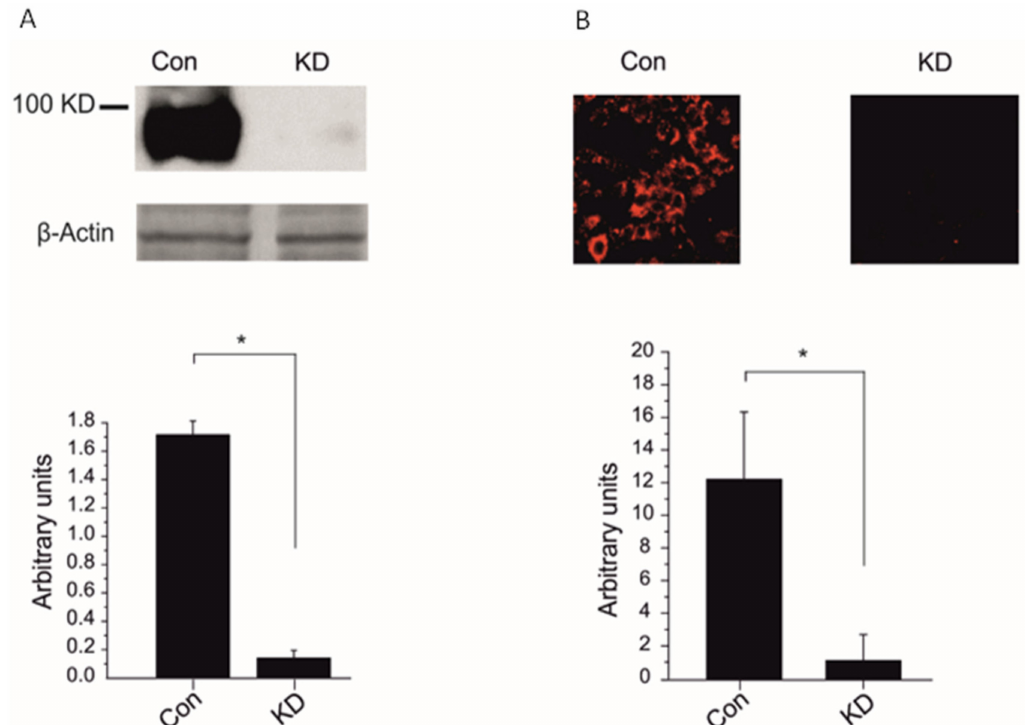
Figure 1. CRISPR/Cas 9 knocked down the δ -ENaC subunit in the A549. ( A ) Upper panel, A549 cell lysate blotted against anti δ -ENaC and β -Actin antibodies. Representative western blot out of three independent biological replicates is shown. A549 cells transfected with either CRISPR/Cas 9 control plasmid (control) or CRISPR/Cas 9 δ -ENaC KO plasmid (KD). The lower panel; mean values of quantitation of three western blots is shown. ( B ) Upper panel, representative confocal microscope image of anti δ -ENaC antibody, is shown. A549 cells transfected with either CRISPR/Cas 9 control plasmid (control) or CRISPR/Cas 9 δ -ENaC KO plasmid (KD). The lower panel; mean values of quantitation of 7 immunofluorescence images are shown. Significant differences are indicated, * p < 0.5, unpaired Student’s t -test, n =